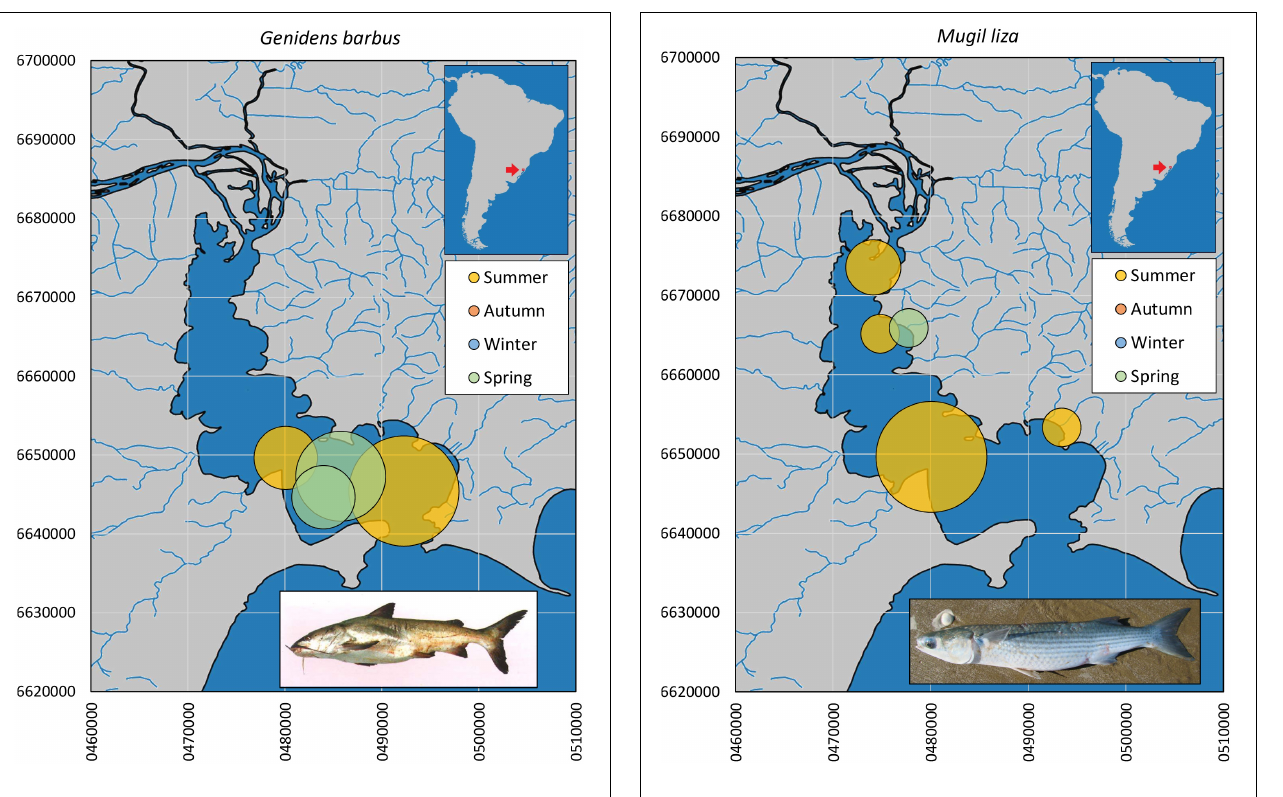
FIGURE 8 | Spatial and seasonal relative abundance of G. barbus in Guaíba Lake, southern Brazil. Bubble area proportional to number of captures per site (7 individuals). Fish photograph from Sverlij, S. available at Fishbase.com. Vector map background from FEPAM open database (http://www.fepam.rs.gov.br/biblioteca/geo/bases_geo.asp). 22J UTM coordinates.